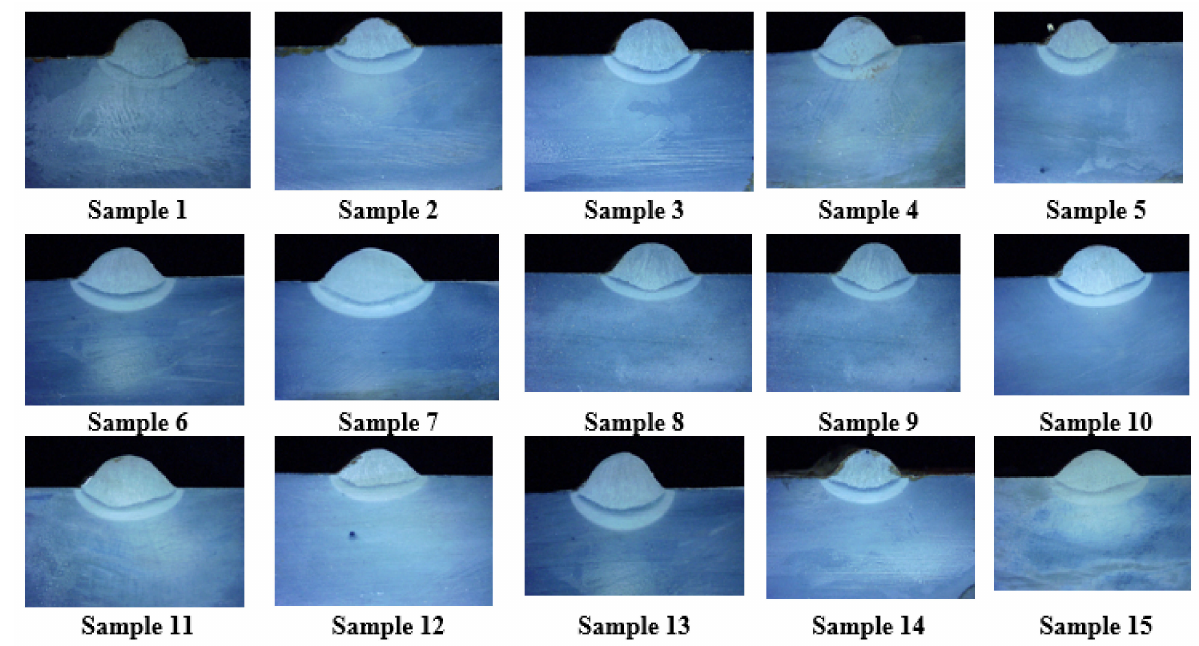
Figure 2. Cross-sections of specimens of single bead deposition for bead geometry